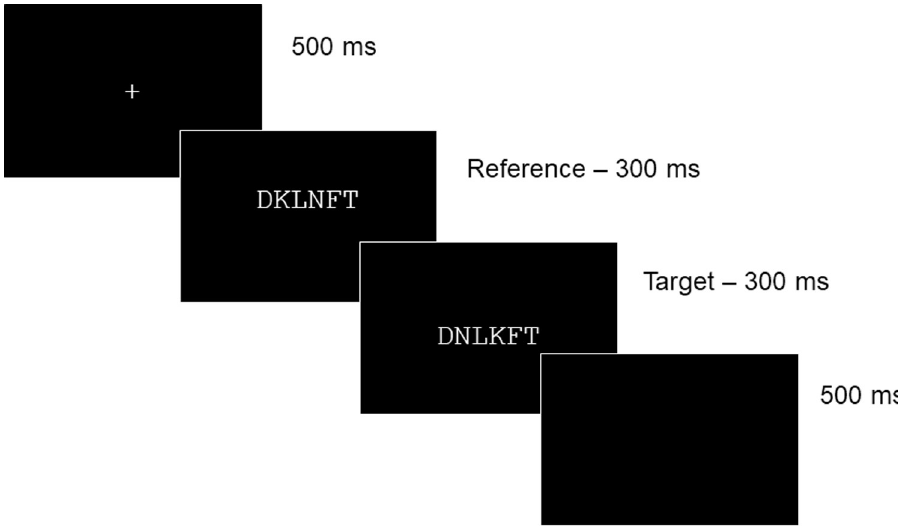
Fig 2. Schematic representation of an experimental trial with an example of a “different” response for transposed- letter stimuli.